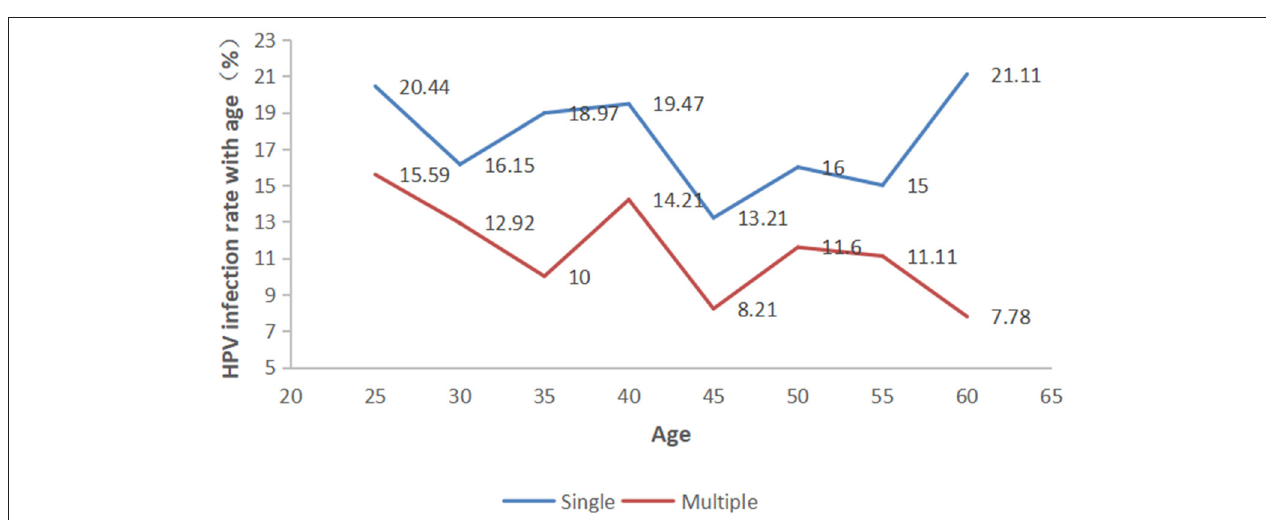
FIGURE 3 | Prevalence of single and multiple HPV infections in each age group ( p <